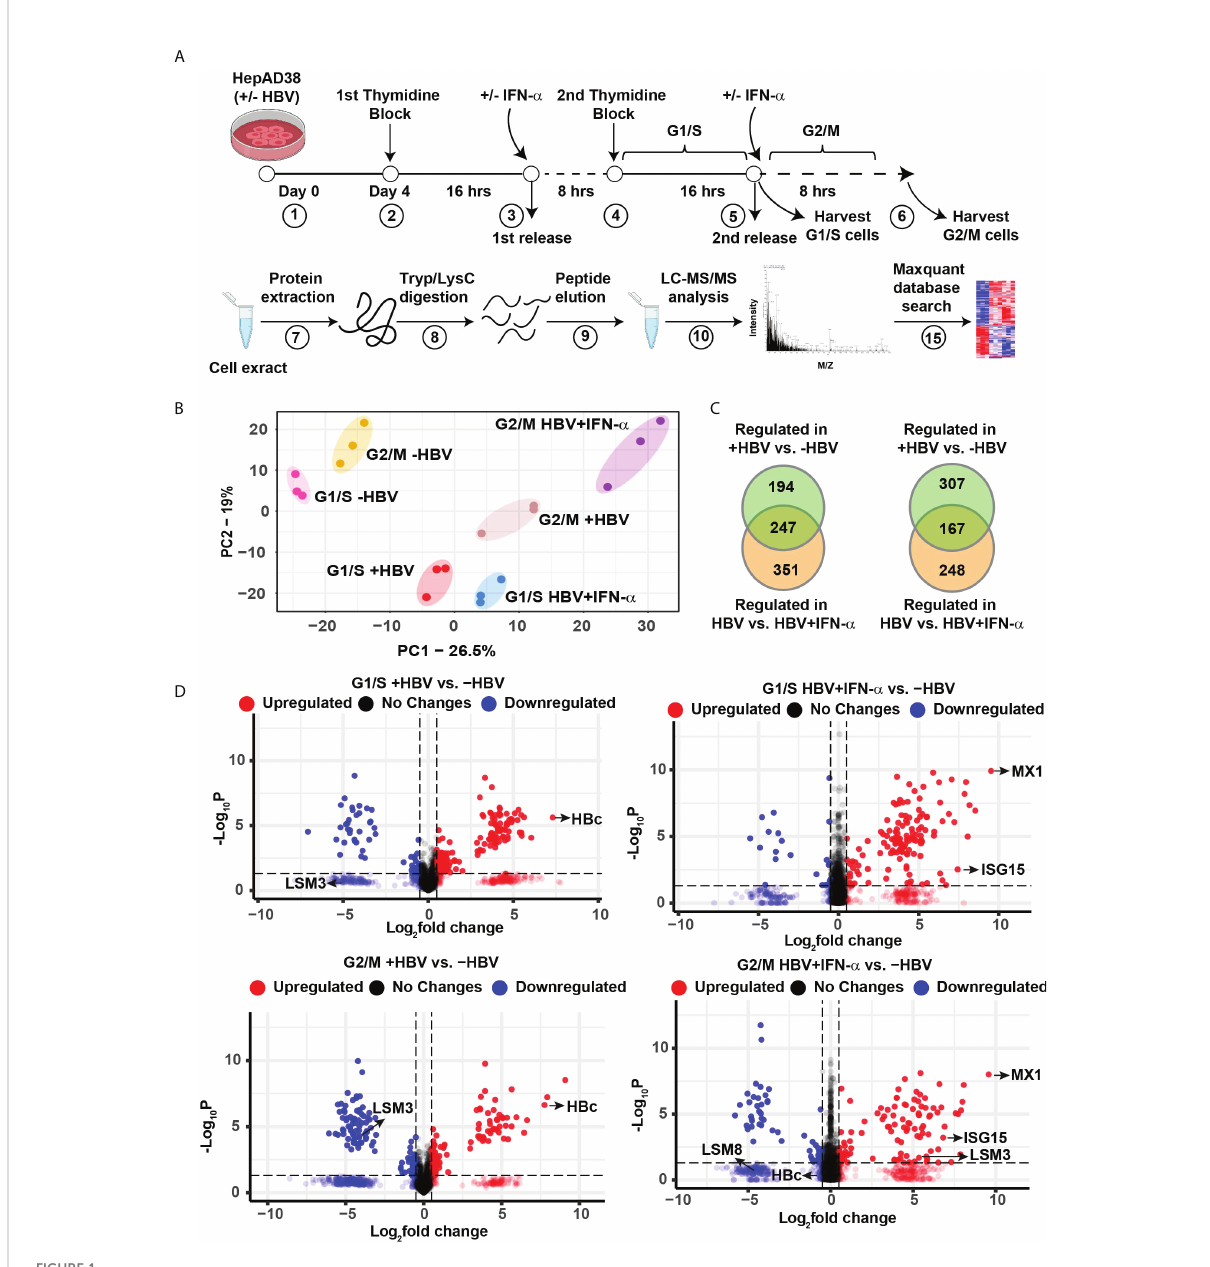
FIGURE 1 Label − free quantitative proteomic analysis of HBV replicating hepatocytes as a function of cell cycle progression and IFN- a treatment. (A) Experimental design and proteomics work fl ow. (B) Principal-component analysis (PCA) segregates the six experimental groups (n=3). (C) Ven diagram of differentially regulated protein (FC>2, p <0.05) in G1/S and G2/M as indicated, comparing HBV replicating vs. non-replicating cells and HBV replicating with (+) or without (-) INF- a (500 ng/ml) treatment. (D) Volcano plots showing distribution of differentially abundant proteins (FC>2, p <0.05) in G1/S and G2/M as indicated, comparing HBV replicating vs. non-replicating cells and HBV replicating with (+) or without (-) INF- a (500 ng/ml) treatment. Each dot represents a